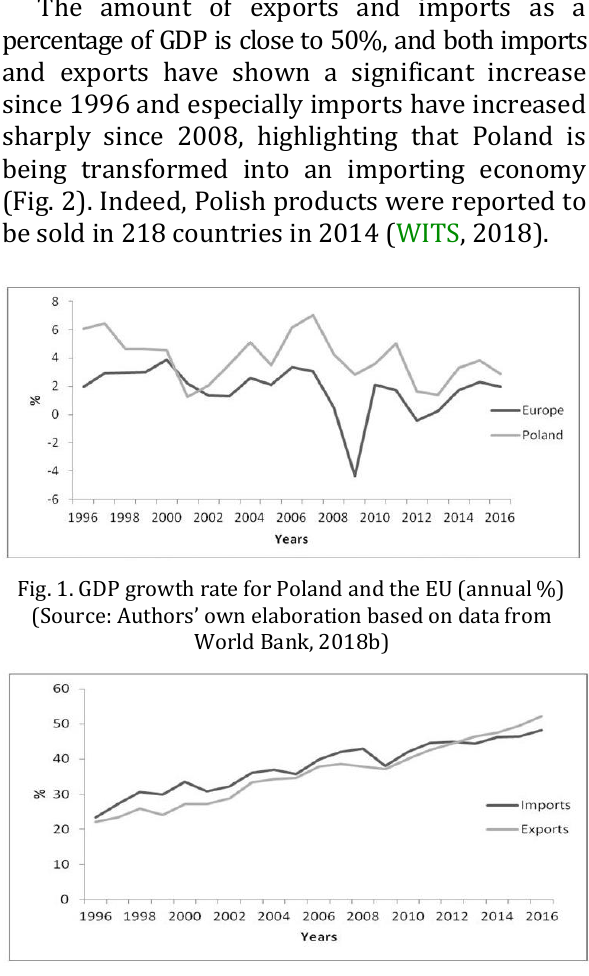
Fig. 2. Exports of goods and services as % of GDP for Poland (Source: Authors’ own elaboration based on data from World Bank